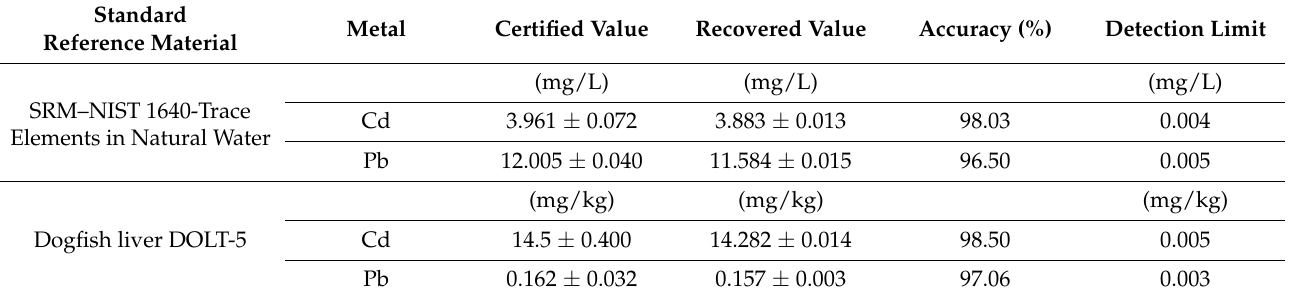
Table 2. Heavy metal concentrations recovered from the standard reference materials and the accuracy and detection limits recorded by ICP-MS